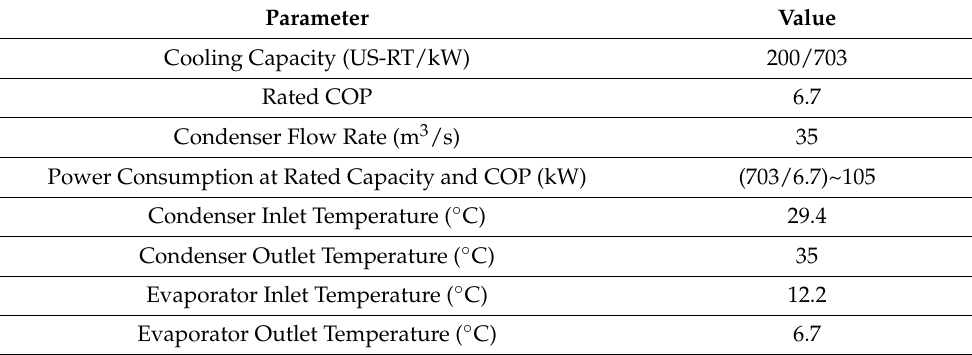
Figure 3. ( A ) schematic and ( B ) T-S diagram of the ORC. Table 2. Specifications of the VCC adopted for this study